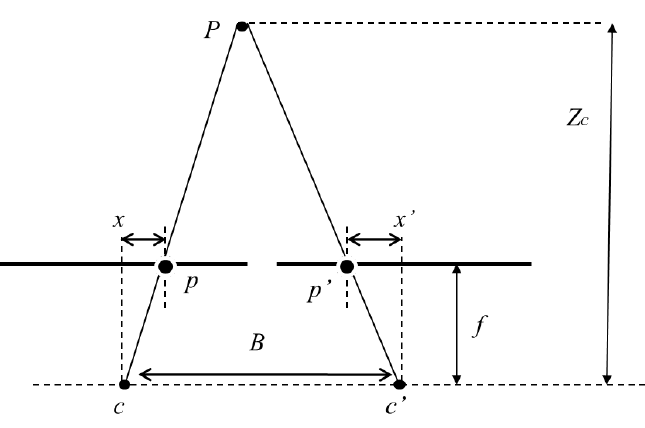
Figure 2. Disparity